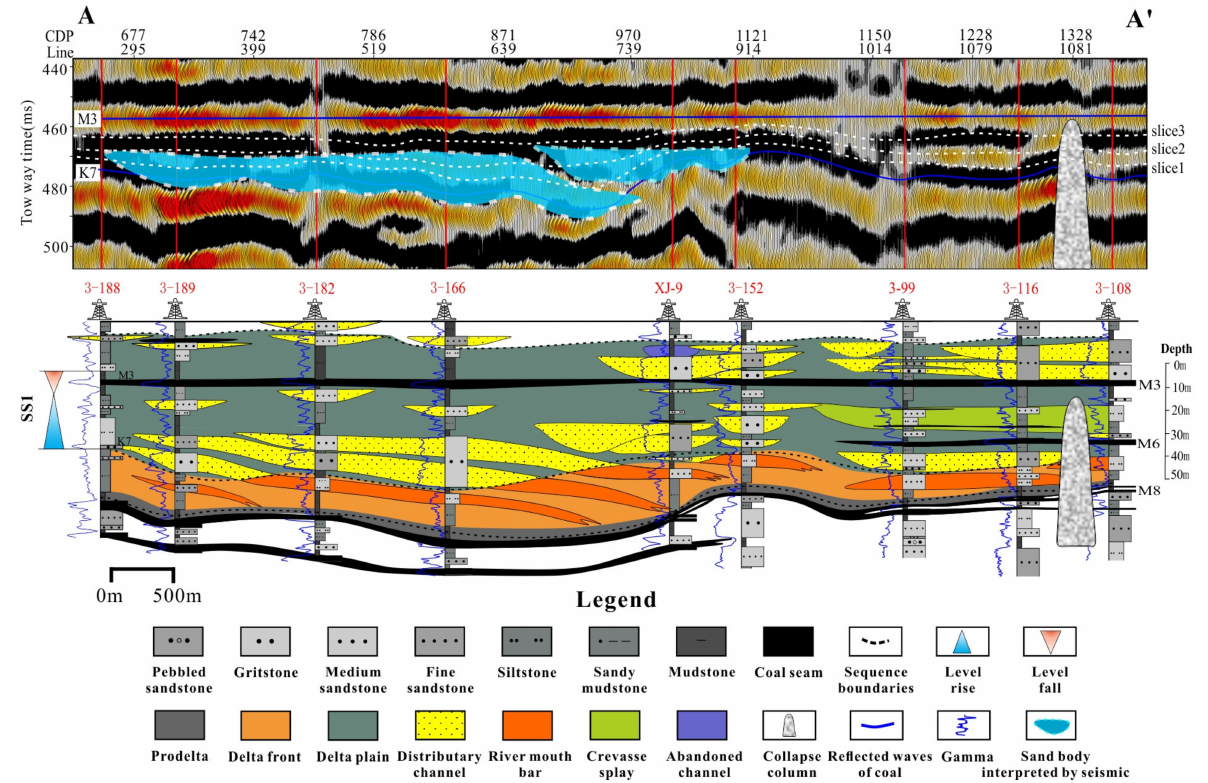
Figure 12. Seismic–geological comprehensive interpretation of sand bodies distribution and sedimen- tary facies (( A – A (cid:48) ) profile).